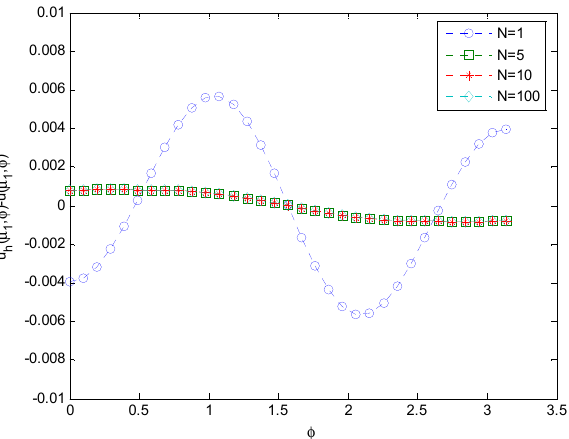
Figure 11. The errors on the artificial boundary against N for Example 3 ( Mesh h /8 )